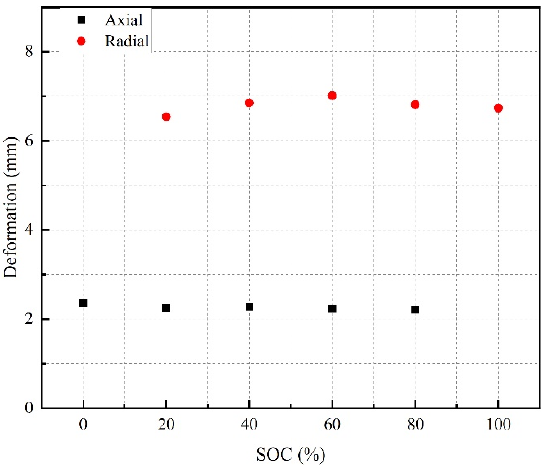
Figure 10. Failure displacement of power battery under different loads.